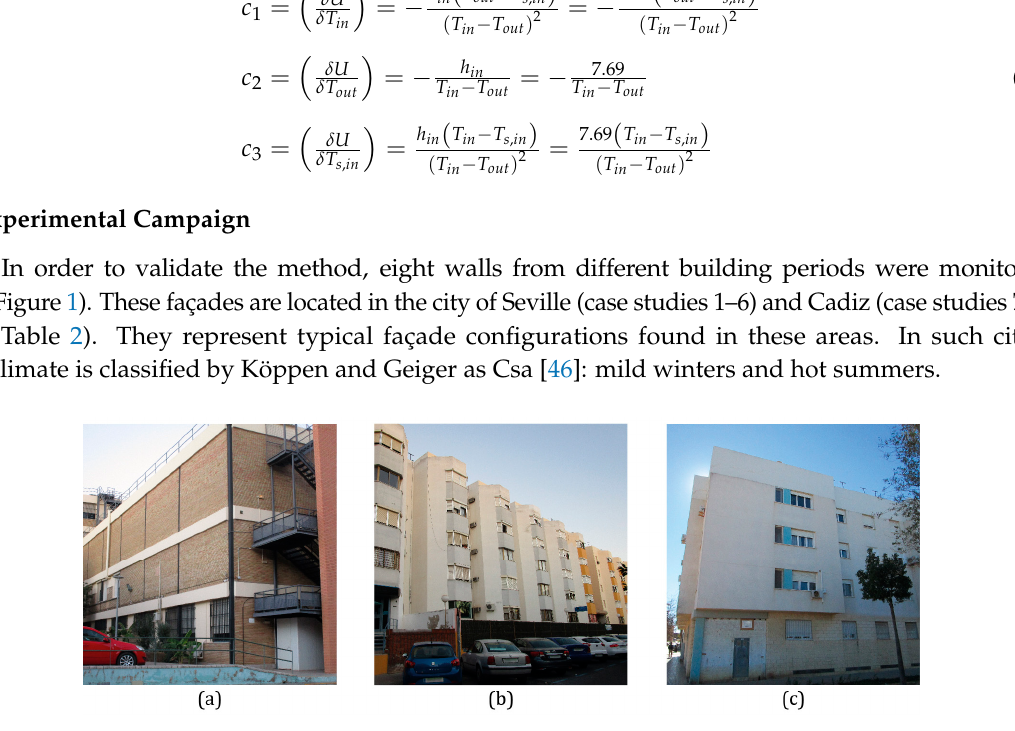
Figure 1 . Façades of some of the analysed buildings: ( a ) C-5 (1966), ( b ) C-6 (1981), and ( c ) C-7 (2004).